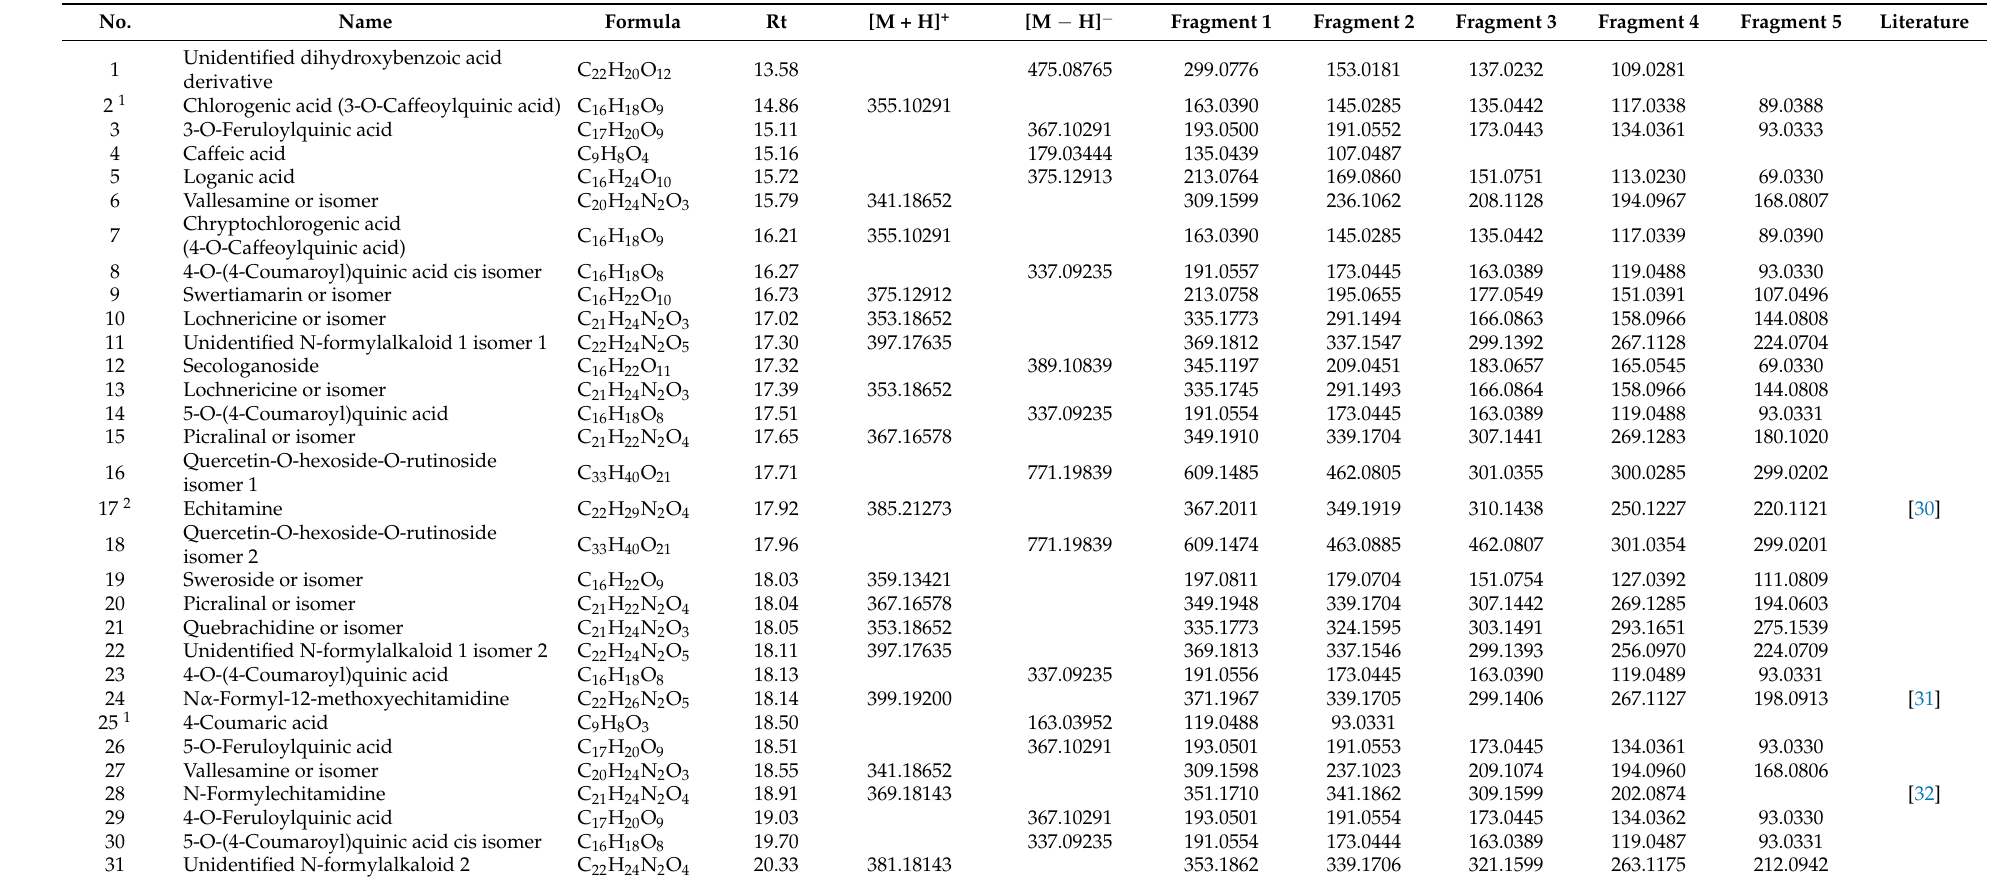
Table 2. Chemical characterization of